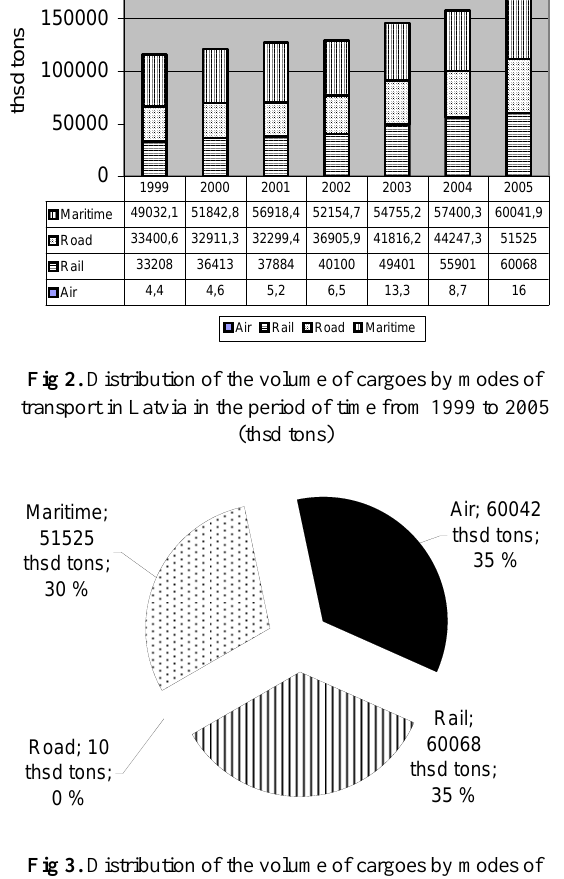
Fig 3. Distribution of the volume of cargoes by modes of transport in Latvia in